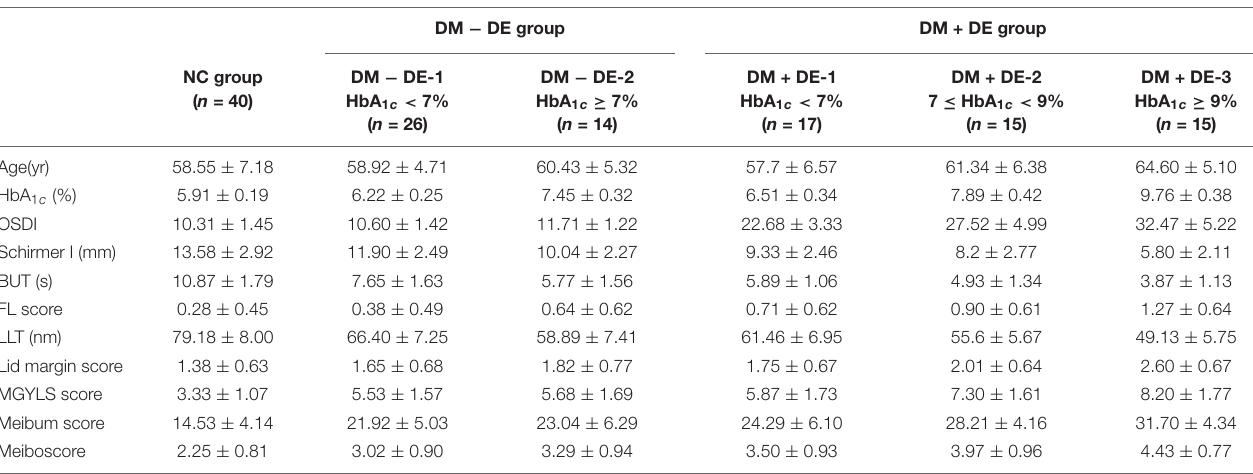
TABLE 4 | Tear film and meibomian gland parameters at different HbA 1 c